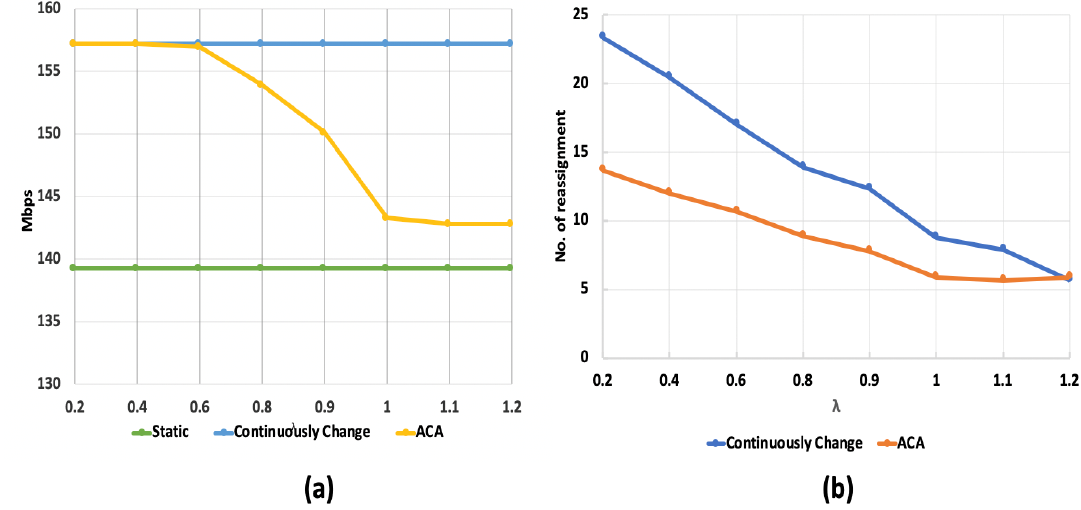
Figure 5. The network topology 1 results, the number of channel reassignments, and the overall throughput with the maximum three NICs, ( a ) throughput comparisons and ( b ) channel reassignment